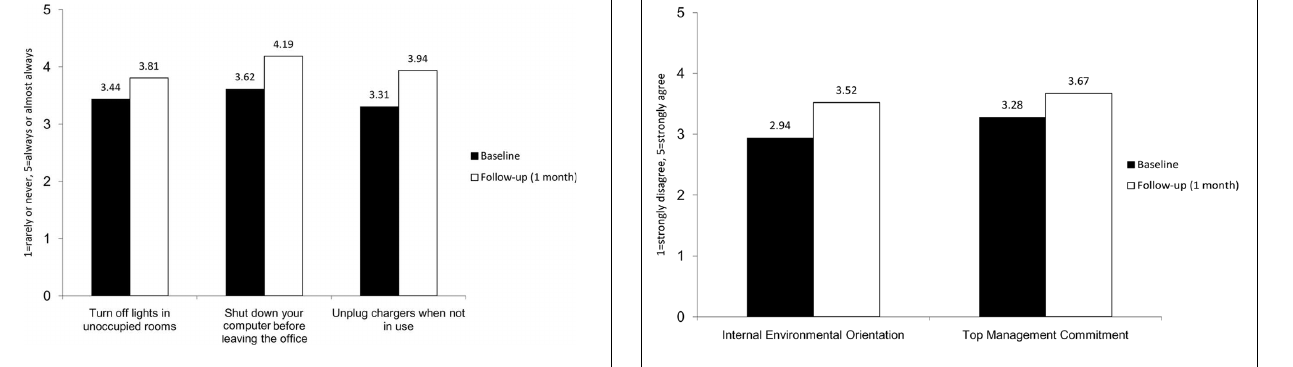
FIGURE 3 | Changes in self-reported energy conservation behaviors. FIGURE 4 | Changes in corporate environmental climate.